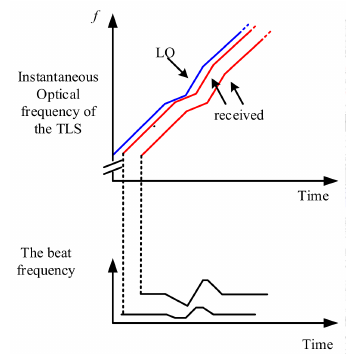
Figure 2. Beating signals are generated from the LO light and received light under the condition of the nonlinear optical frequency tuning of a TLS.